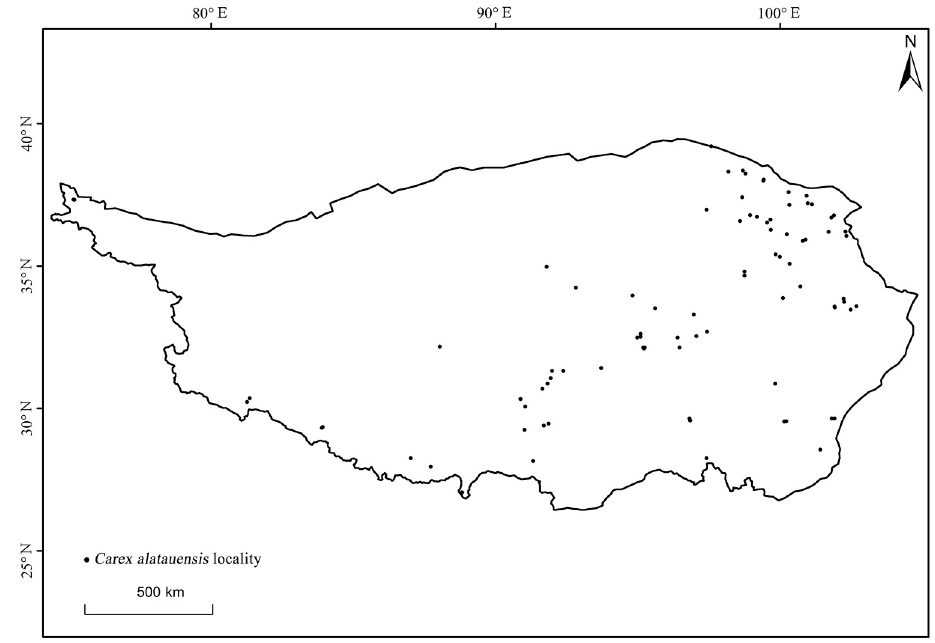
Figure 1. The occurrence sites of Carex alatauensis on the Qinghai–Tibet Plateau.